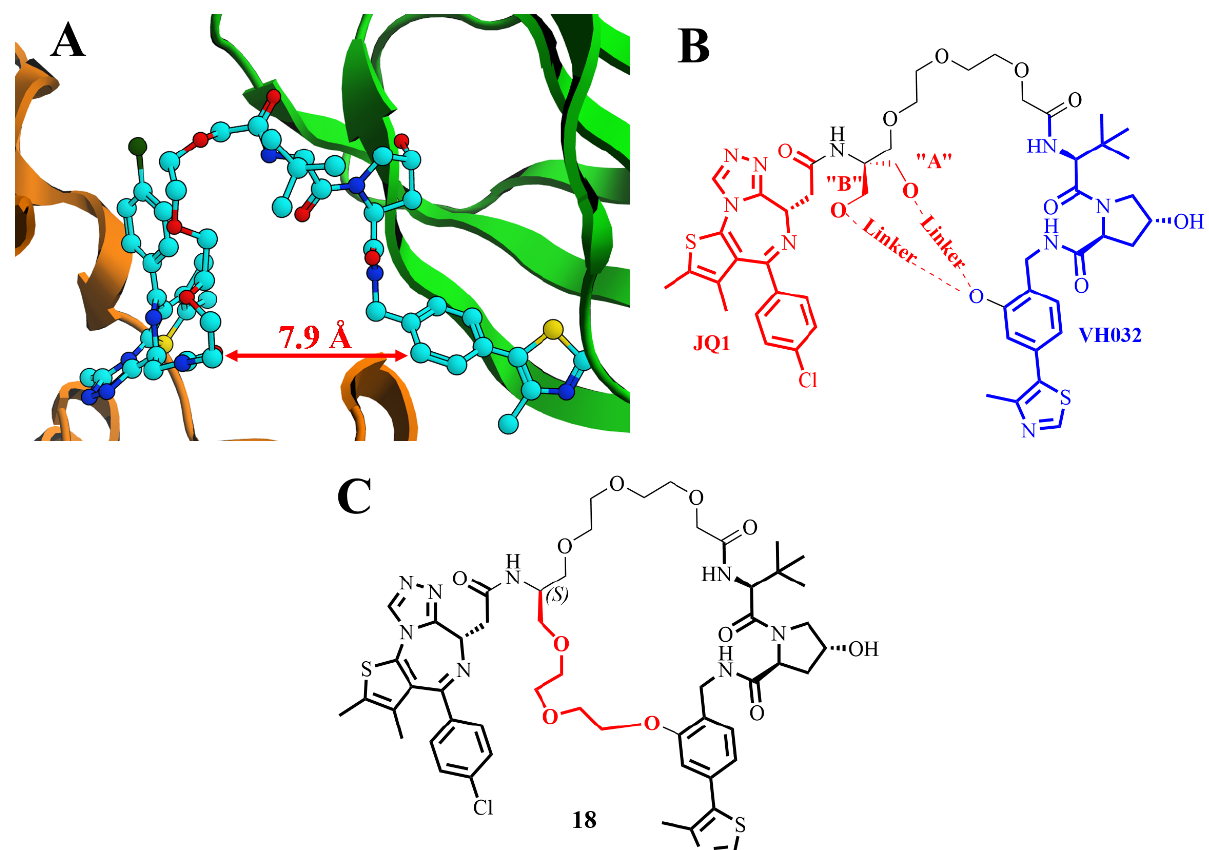
Figure 20. ( A ) Crystal structure of MZ1 in complex with Brd4BD2 and VHL-EloB-EloC (PDB: 5T35). ( B ) The two cyclization vectors “A” and “B” investigated computationally. ( C ) Structure of com- pound 18 .